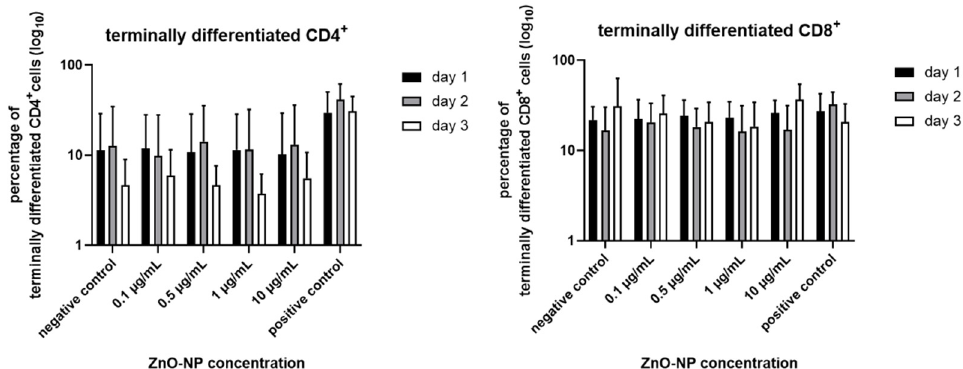
Figure 7. Ratio of terminally differentiated cells in CD4 + and CD8 + subpopulations. Proportions appear to decline over time but remain unaffected by NP incubation. Alterations are not statistically significant. Data represent the mean +/ − standard deviation (n = 9 for day 1 and 2, n = 7 for day 3 for CD4 + cells; n = 6 for day 1 and 2, n = 5 for day 3 for CD 8 + cells).